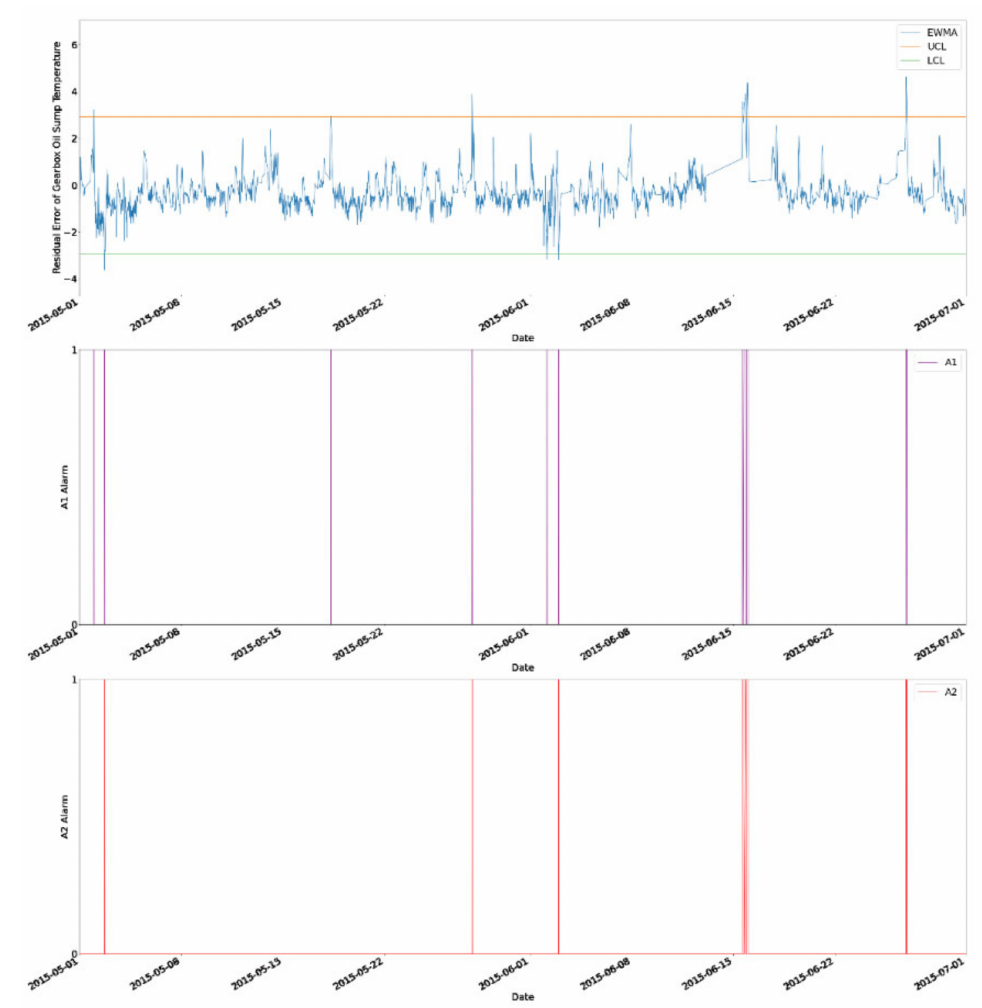
Figure 24. EWMA Chart with A1 and A2 Alarms from May 2015 to July